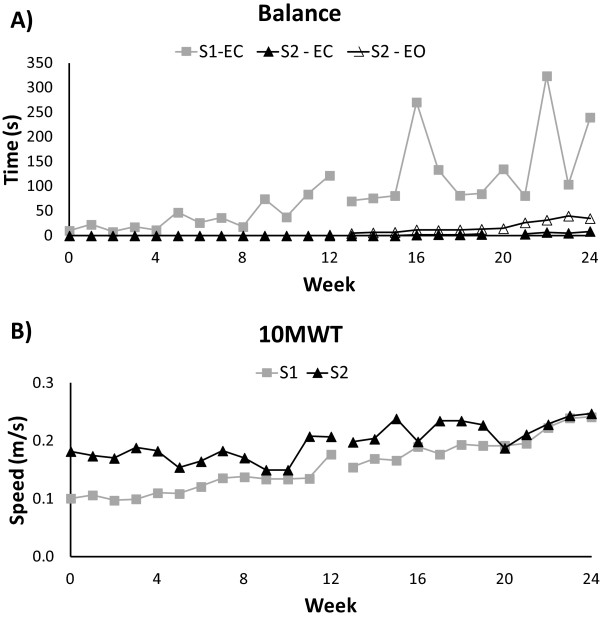
Progression of A) balance and B) walking speed over the course of the laboratory-based (Weeks 0–12) and home-based (Weeks 12–24) training. Balance was timed with eyes closed (EC) for both subjects, and eyes open (EO) only for S2. There was missing data at week 20 for S2 because balance with eyes closed was not attempted due to a headache and discomfort.